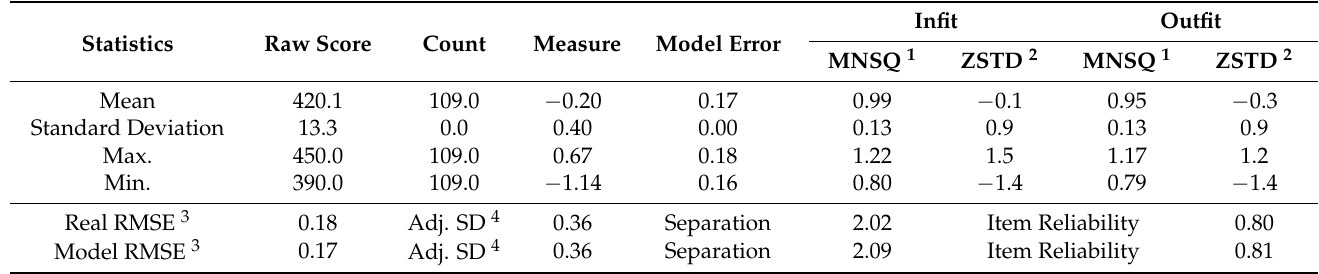
Table 9. Statistical summary of items (innovative behaviour).